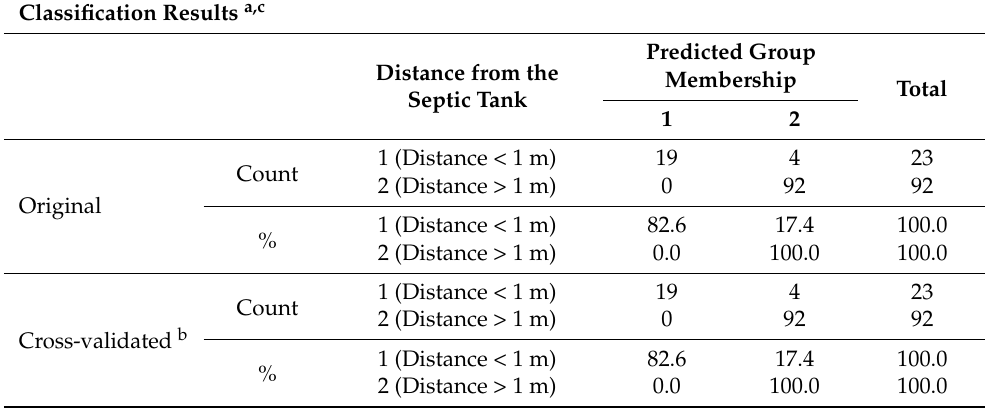
Table 3. Classification results of the discriminant analysis for the location of monitoring wells.